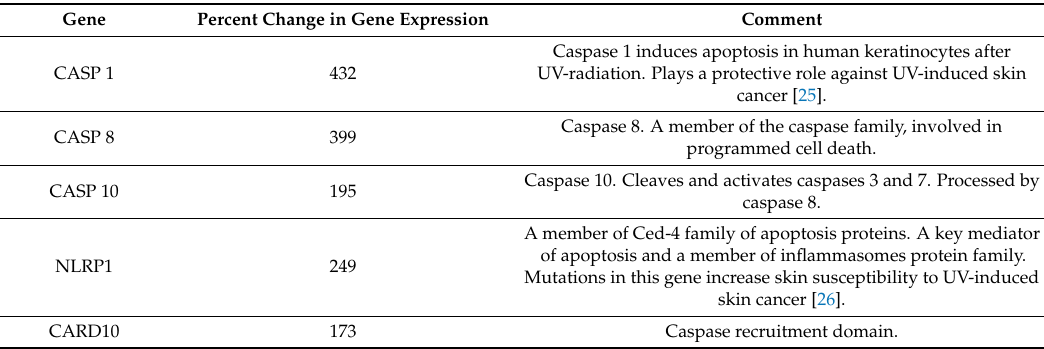
Table 2. GHK and Gene Expression of Programmed Cell Death (Apoptosis)